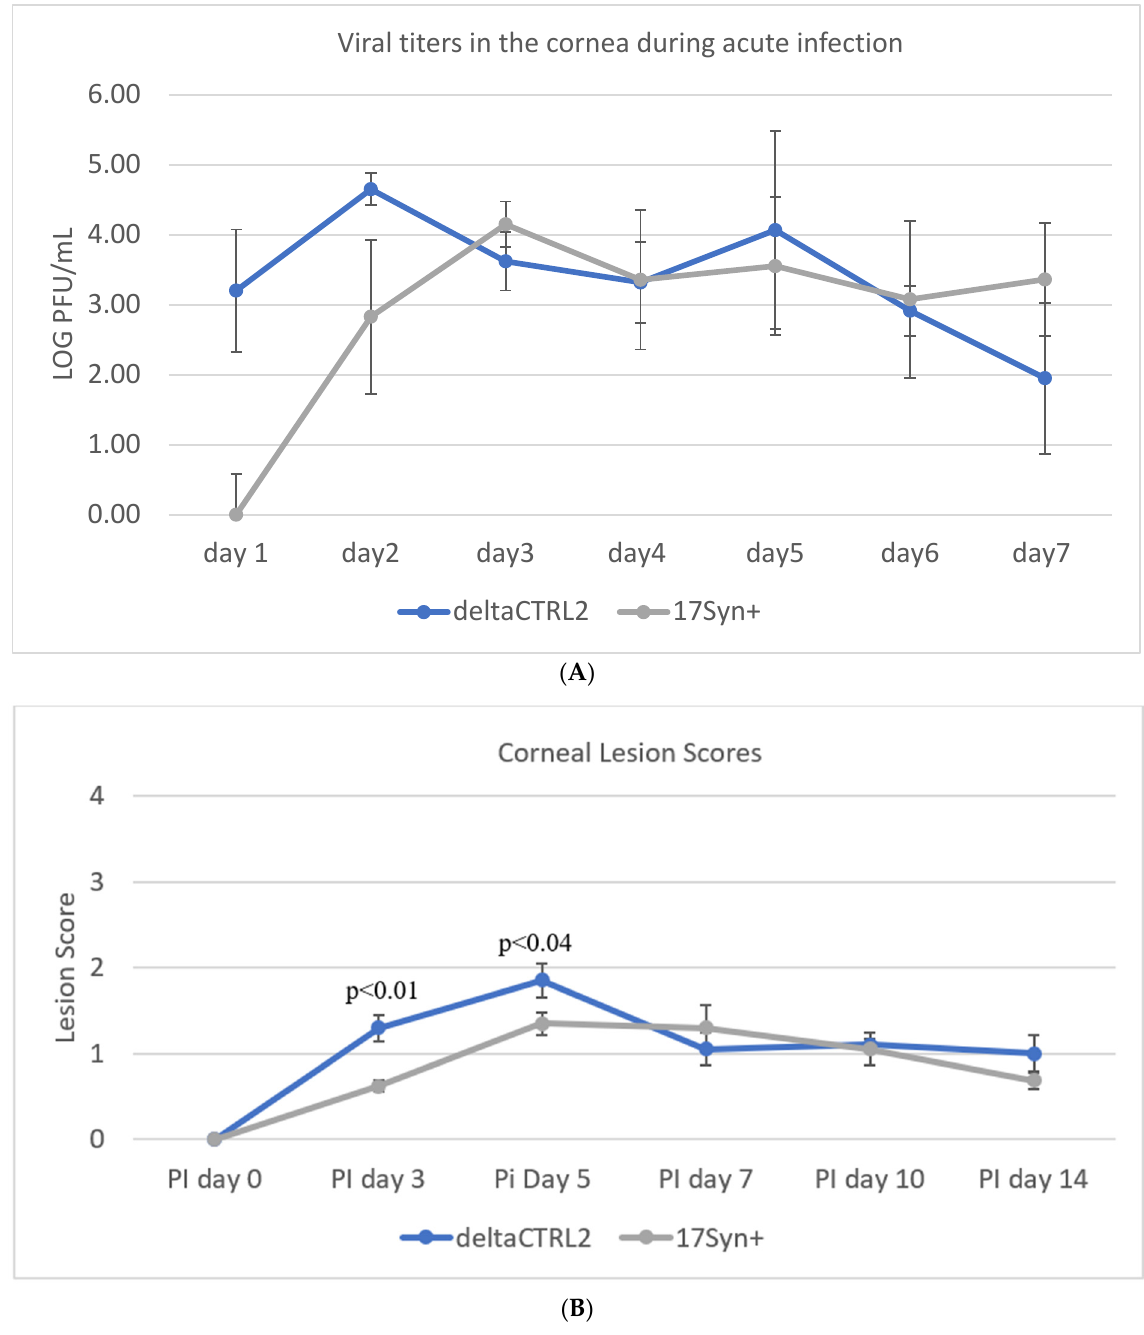
Figure 1. Ocular replication of wild-type 17Syn+ and Δ CTRL2 in rabbit corneas. ( A ) Ocular swabs were taken following infection from 1–7 dpi and plaque-forming units were calculated for both cohorts of rabbits during the acute infection. There was a significant increase in pfu/eye from the swabs of the Δ CTRL2-infected rabbits on 1–2 dpi. ( B ) Slit lamp examinations were performed on a separate cohort of rabbits to assess the HSV-1 lesion size and severity between the two virally infected groups. Similar to the pfu/eye, there were higher scores for rabbits infected with Δ CTRL2 on days 3–5 post-infection, indicating the lesions in those eyes were more significant in the earlier days. Statistical analyses were performed by one-way ANOVA ( n = 10).